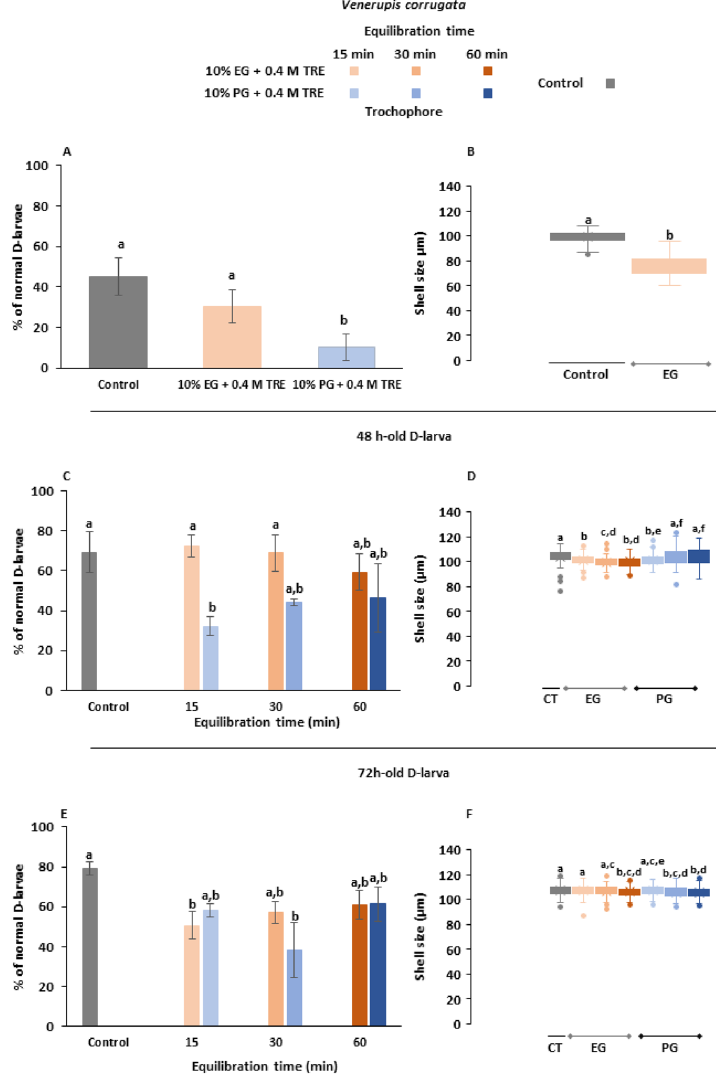
Figure 4. Post-thaw fitness parameters on larvae of Venerupis corrugata cryopreserved at trochophores, 48 and 72 h-old D-larval stages: (A) survival of cryopreserved trochophores; (B) shell size of developed D-larvae from cryopreserved trochophores; (C) survival of cryopreserved 48 h-old D-larvae; (D) shell size of developed D-larvae from cryopreserved 48 h-old D-larvae; (E) survival of cryopreserved 72 h-old D-larvae; (D) shell size of developed D-larvae from cryopreserved 72 h-old D-larvae. Larvae were cryopreserved using two CPA solutions: 10% ethylene–glycol (EG) + 0.4 M trehalose (TRE) and 10% prophylene-glycol (PG) + 0.4 M TRE (final concentrations), both prepared in filtered sea water (FSW). Increasing equilibrium times were tested on D-larvae. Results are expressed as Mean normal D-larval percentage ± Standard Deviation, SD (n = 100, 3 replicates per treatment) or as box plots for shell size assessments (µm) considering mean value (Mean ± Standard Deviation, SD) (n = 35, 3 replicates per treatment). Different letters show statistical differences with p ˂